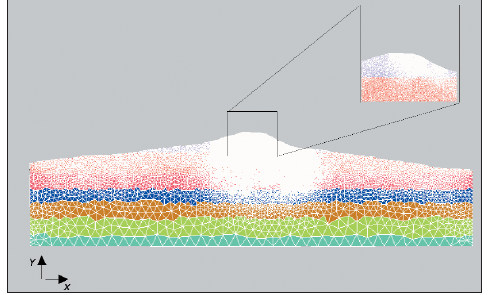
Fig. 5. Stratifications of the elastic medium and grid used in the FE calculations; zoom of the summit zone is